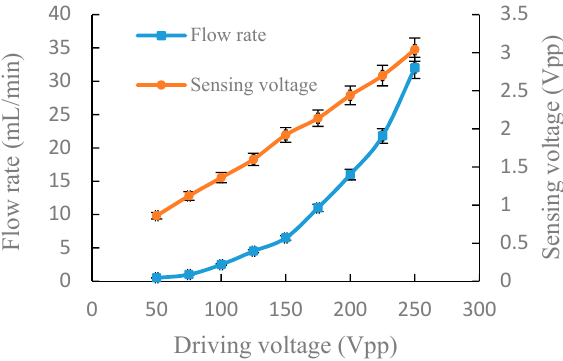
Figure 8. Output flow rate and sensing voltage under a fixed frequency of 100 Hz in parallel connection.